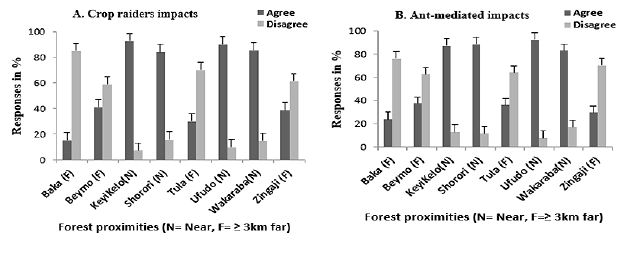
Fig. 5. Farmers’ responses regarding (A) crop raiding and (B) ant-mediated impacts at specific forest proximities: a high degree of raiding in homegardens near to forest edges (Kayikela, Shorori, Ufudo, and Wakaraba) and relatively little raiding far from the forest edges (Baka, Beymo, Tula, and Zingaji). The statistical interpretations of the patterns are found in the text. Error bars are standard error. The sample size is found in Table